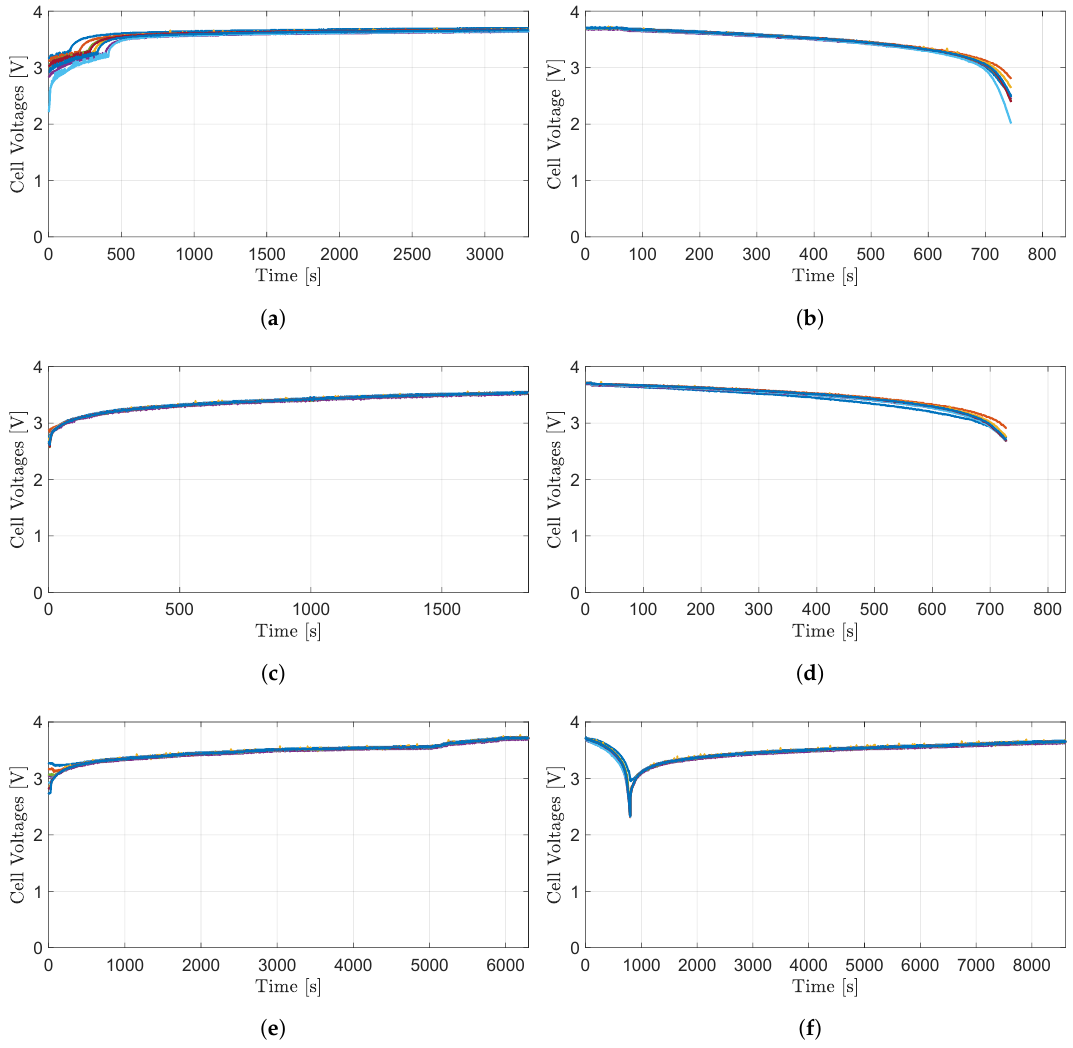
Figure 14. ( a ) Cell charging voltages vs.time without the balancing circuit; ( b ) cell discharging voltages vs. time without the balancing circuit; ( c ) cell charging voltages vs. time with the proposed balancing circuit; ( d ) cell discharging voltages vs. time with the proposed balancing circuit; ( e ) cell charging voltages vs. time with the proposed balancing circuit with significant voltage differences; ( f ) cell discharging and charging voltages vs. time with the proposed balancing